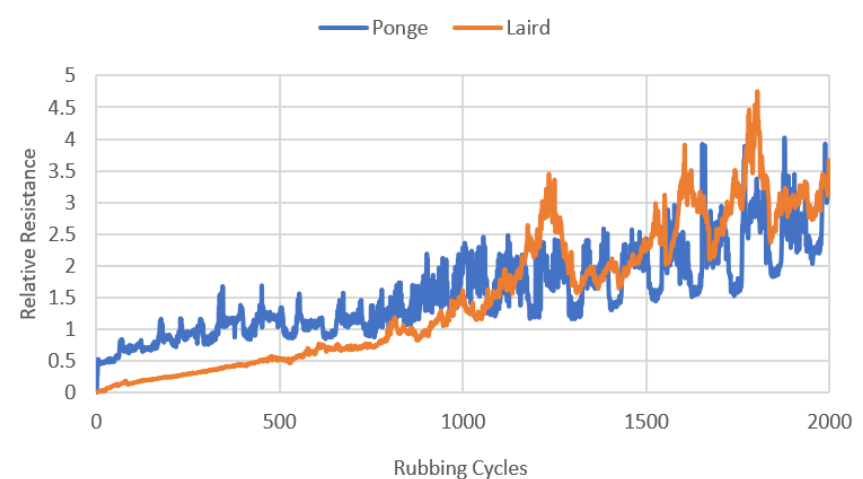
Figure 11. The average relative resistance of the electroconductive strips versus rubbing cycles for the Ponge and 3050–525/Laird electro-conductive